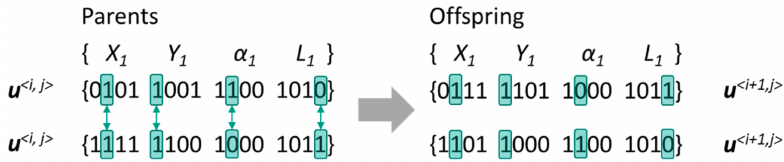
Figure 5. Workflow for the multi-point parameterized binary crossover for µ =